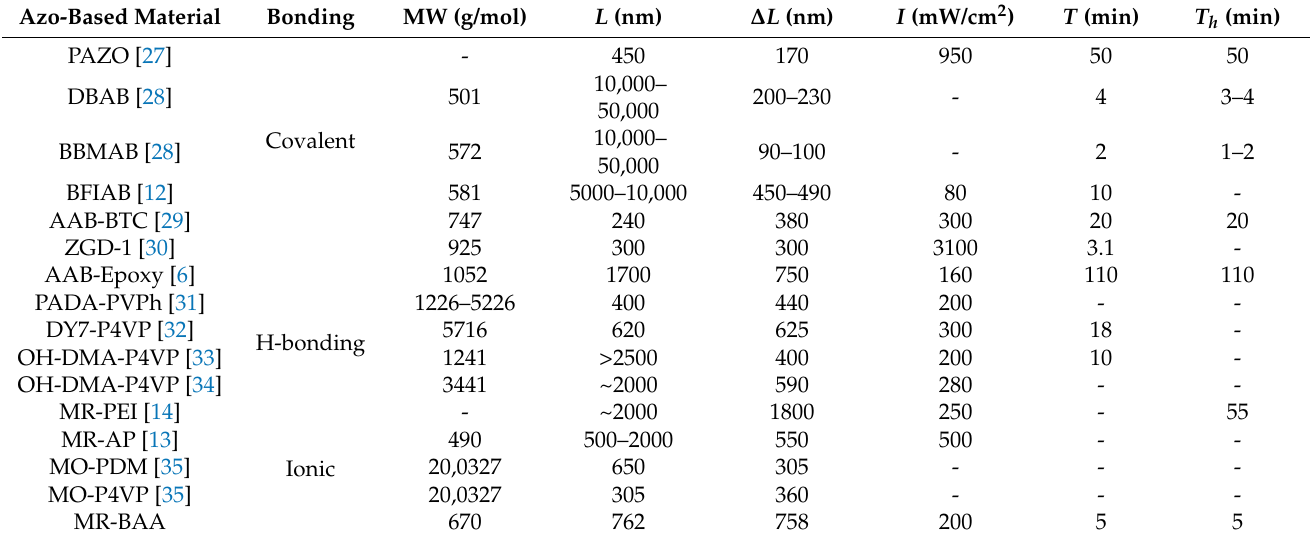
Table 1. A list of SRGs made of various azobenzene compounds with the featured